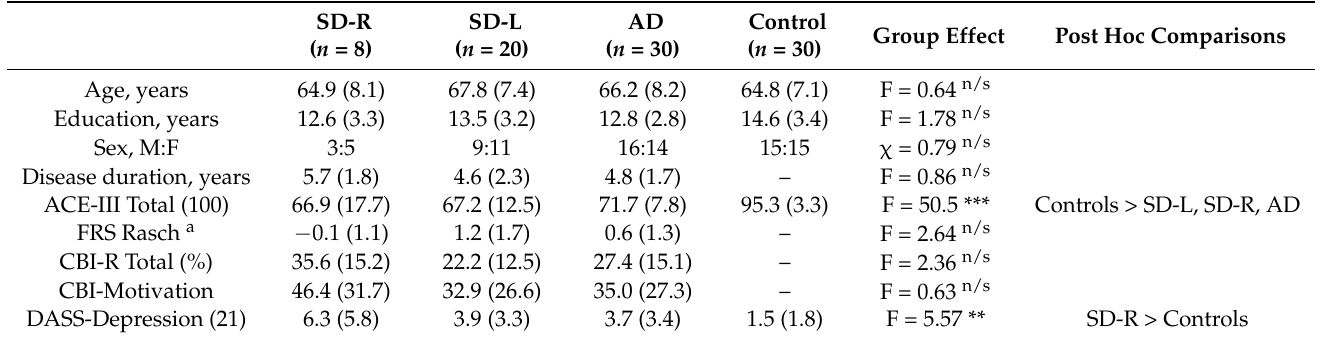
Table 1. Demographic, clinical, and cognitive characteristics of the study